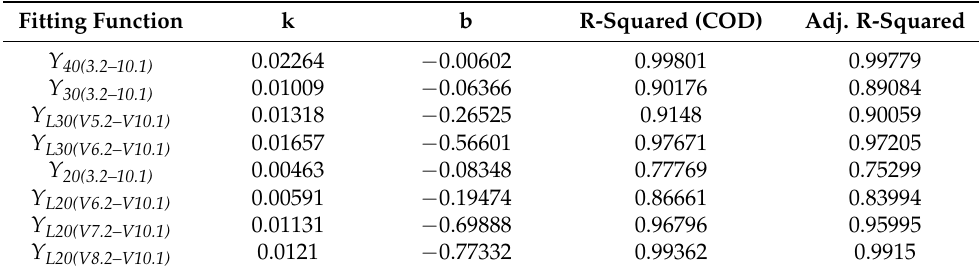
Table 1. Fitting parameters for different fins.